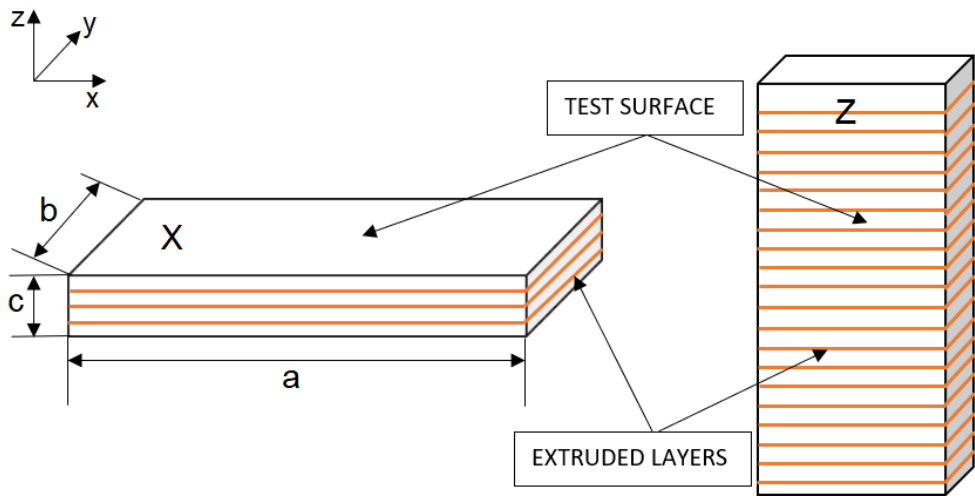
Figure 1. Dimensions and designation of sample types X and Z according to building orientation (xy – reference plane parallel to building platform).